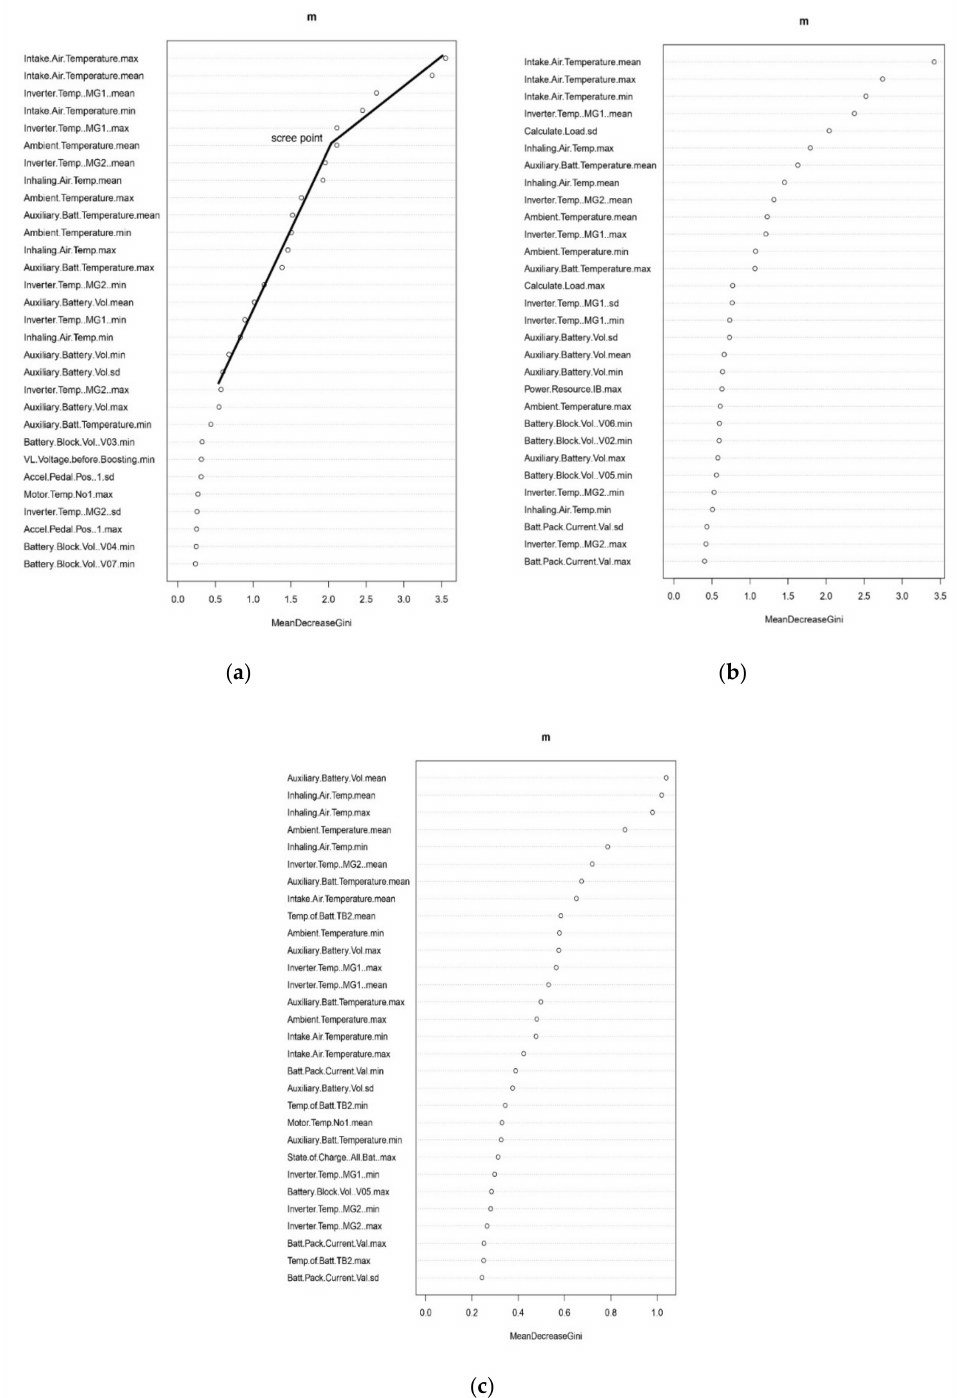
Figure 5. Ten minute basis feature importance of vehicle parts according to mileage interval changes: ( a ) 30,000 vs. 50,000 km; ( b ) 50,000 vs. 60,000 km; ( c ) 60,000 vs. 70,000